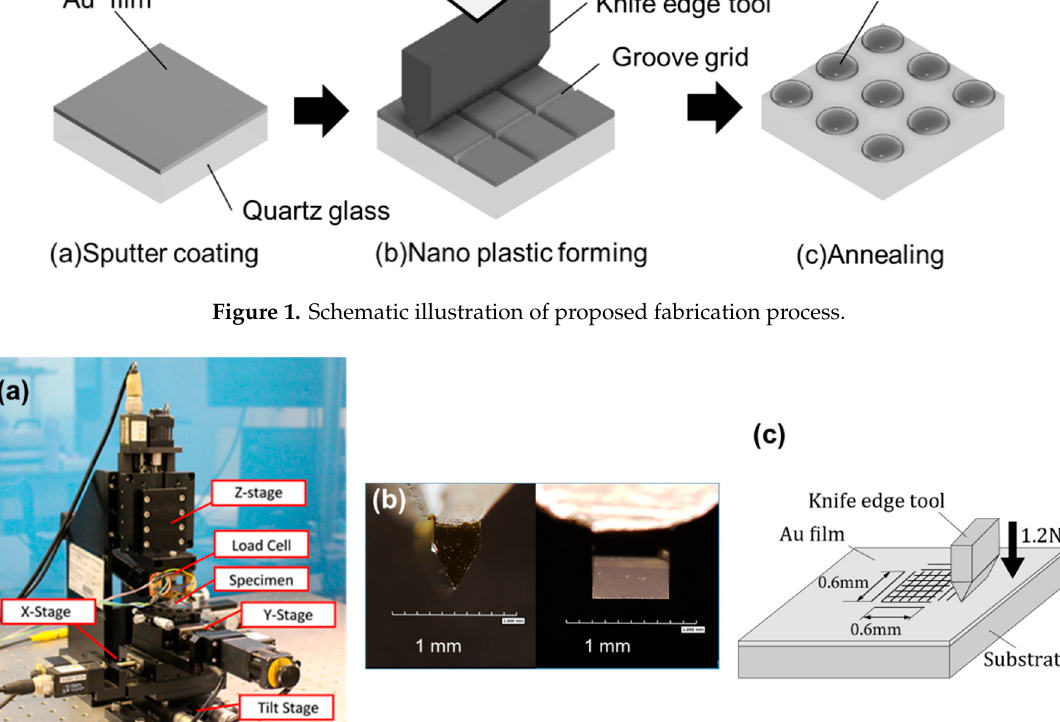
Figure 2. Nano plastic-forming device and knife edge tool made of single crystal diamond. ( a ) whole image of the device; ( b ) optical microscope image of the tool; ( c ) illustration for nanogroove fabrication method. Table 1. Experimental conditions of first-layer nanodot Table 1. Experimental conditions of first-layer nanodot array.